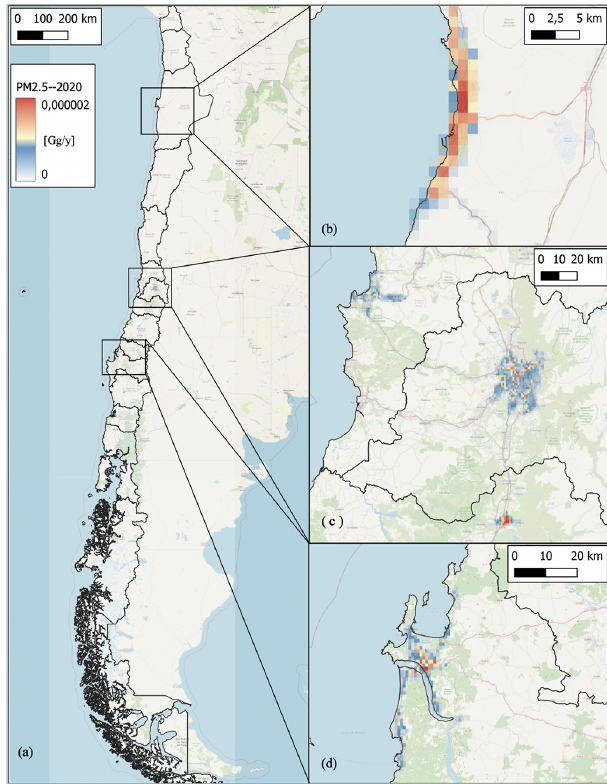
Figure 6. Spatial disaggregation of PM 2 . 5 exhaust emissions across the country (a) , in Antofagasta (b) , in the metropolitan region (c) and in Biobío–Concepción (d) , 2020, as a fraction of Ggyr − 1